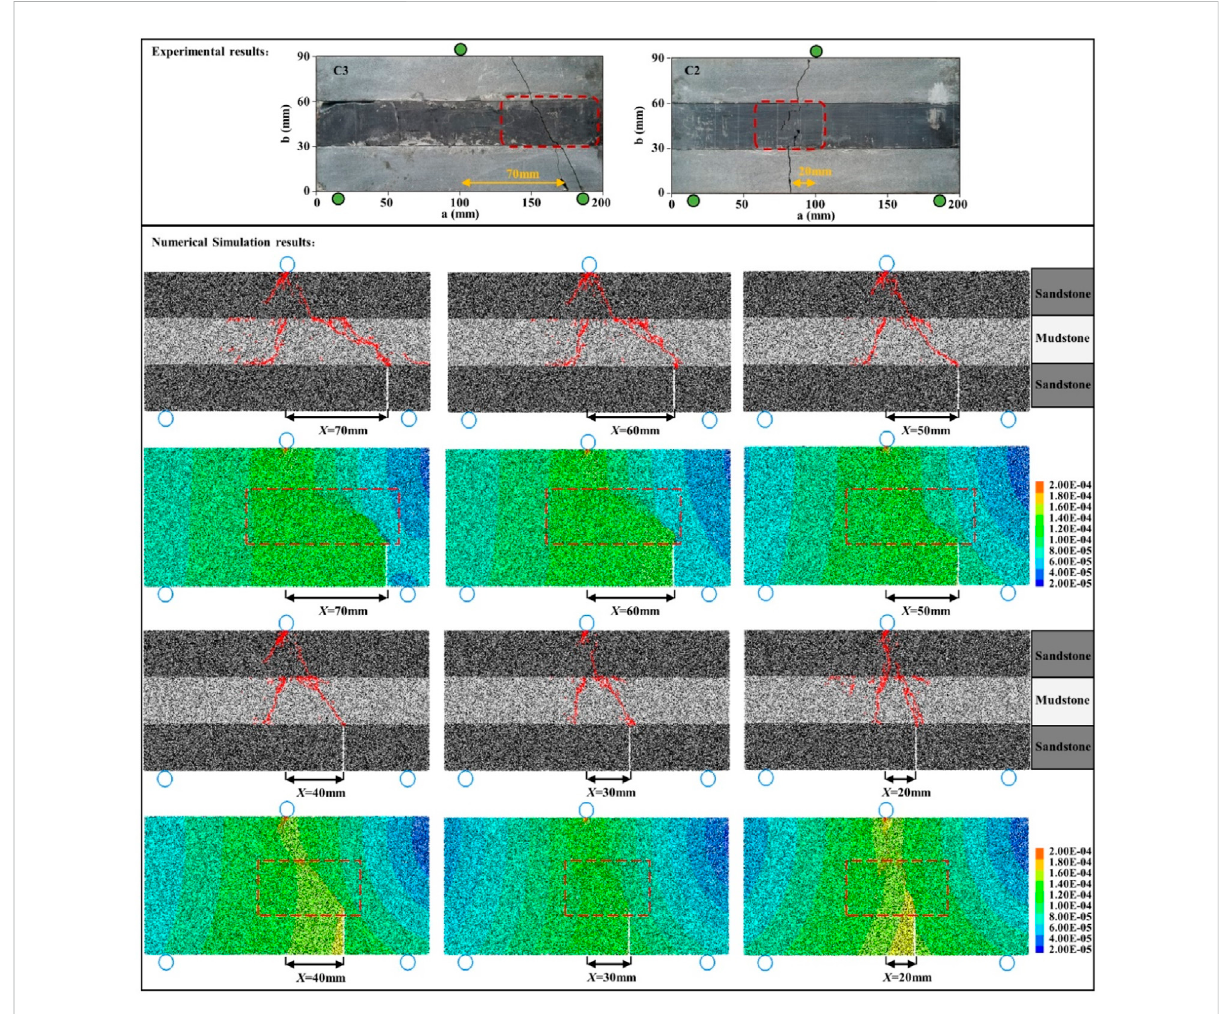
FIGURE 11 Crack propagation paths and surface displacement clouds for S-M-S model with different X